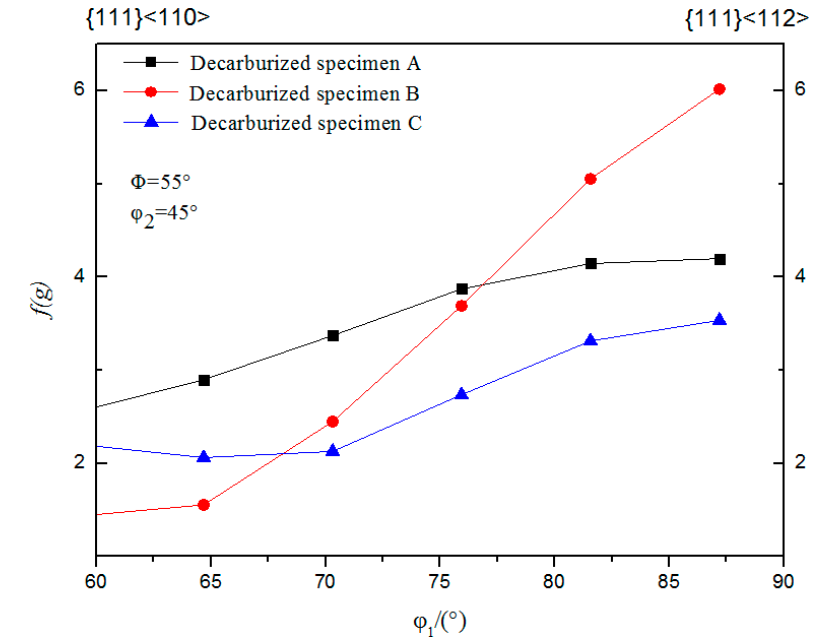
γ ) texture in di ff erent Figure 10. Variety of Gamma( γ ) texture in different specimens. Figure 10. Variety of Gamma(